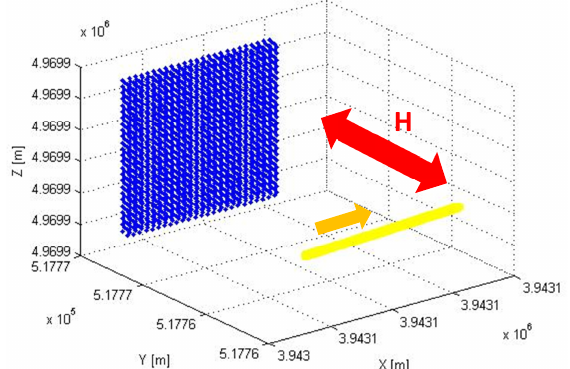
Figure 3. Blue: regular object points distribution. Red: distance between object points and the simulated trajectory